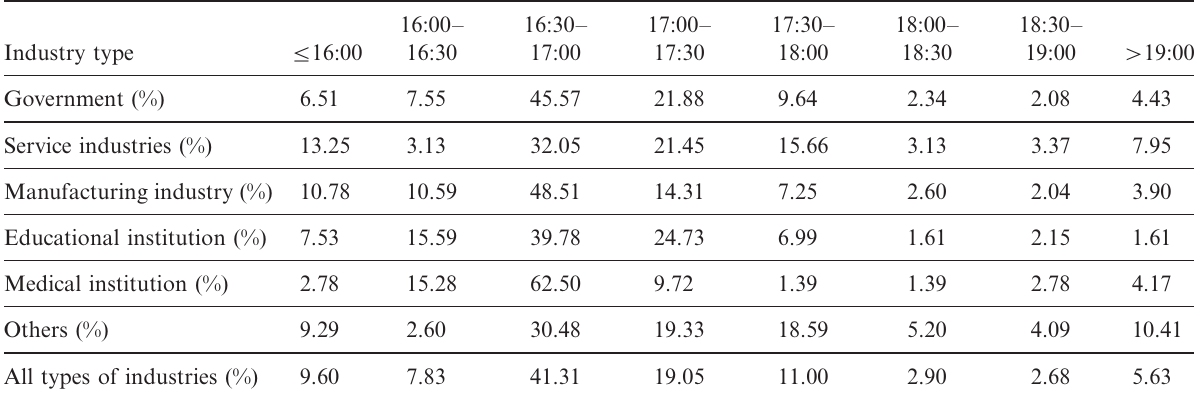
Table 3. Current distribution of the departure time from work